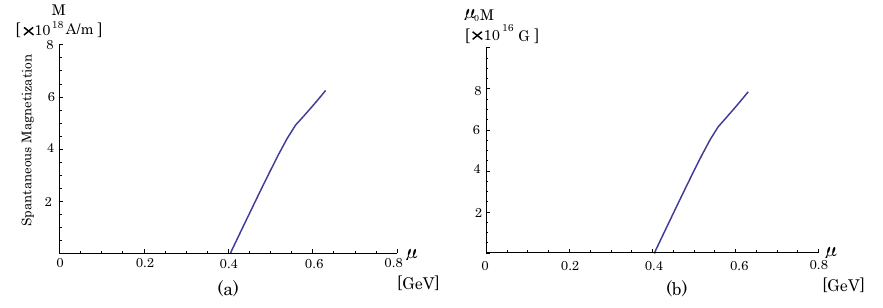
Figure 4. (a) The spontaneous magnetization and (b) the field strength obtained by multiplying the magnetic permeability of vacuum are depicted as a function of the quark chemical